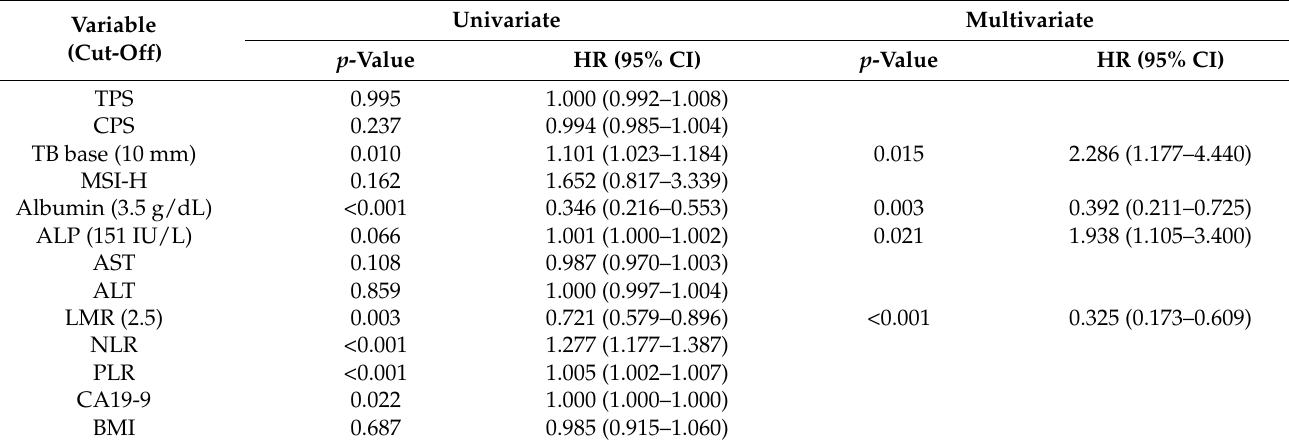
Table 3. Cox analysis